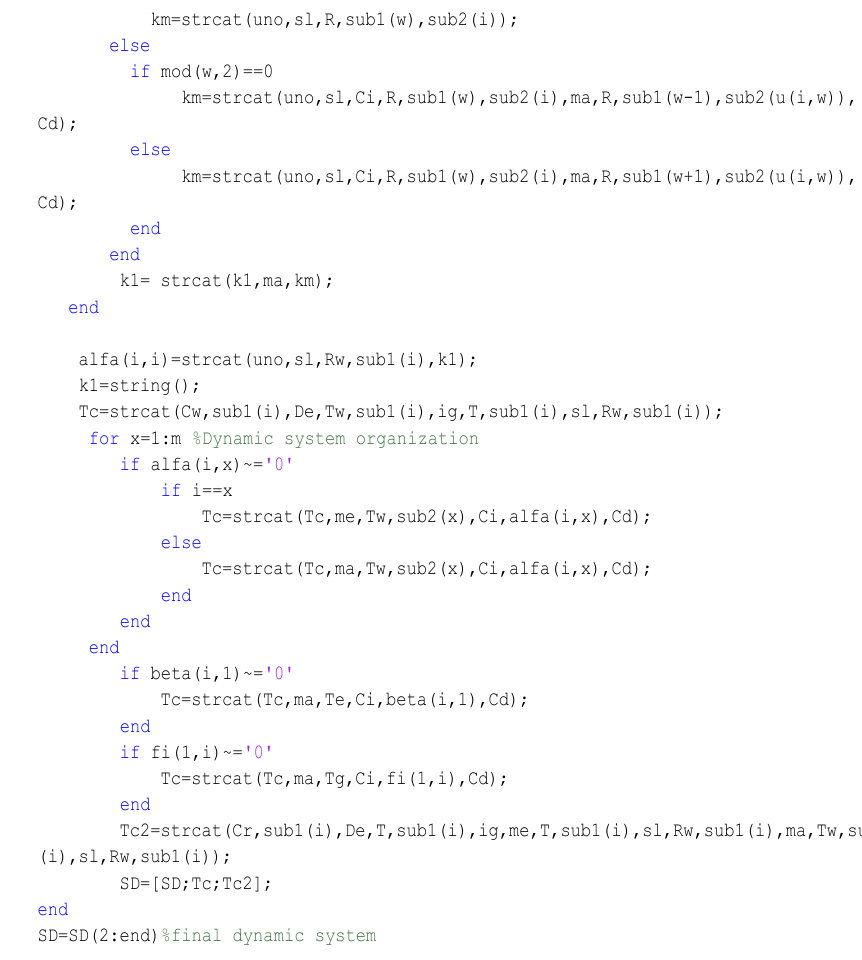
Figure A2. Code to generate mathematical models (part b).